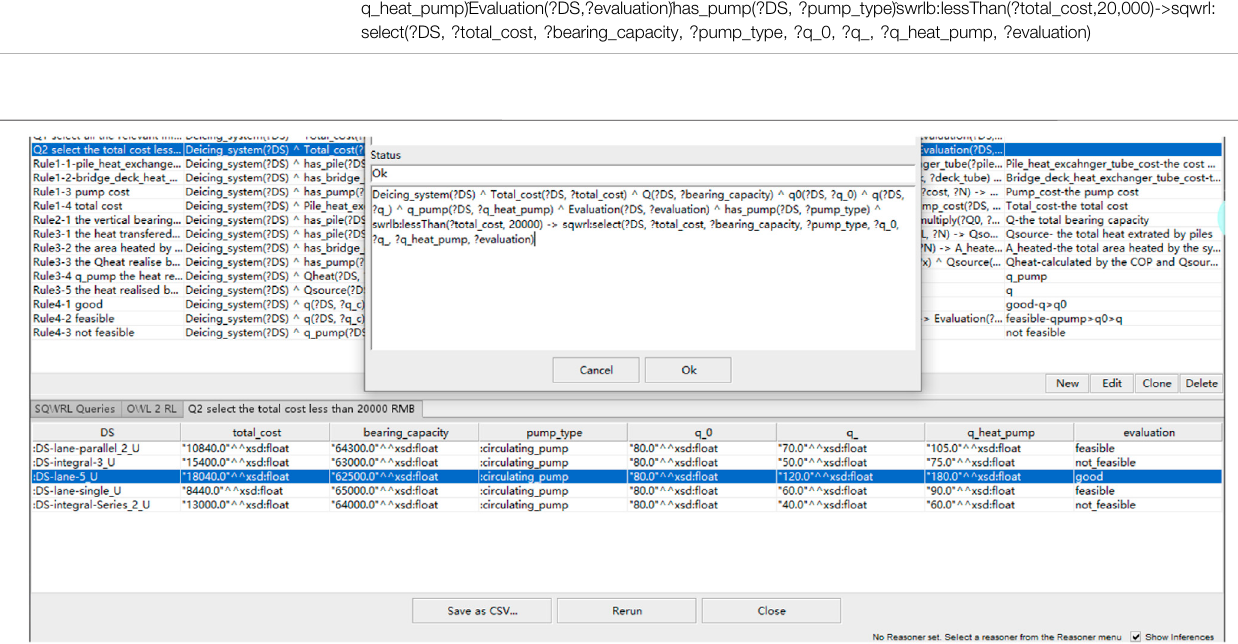
TABLE 8 | SQWRL rules to query total cost less than 20,000 RMB. SQWRL